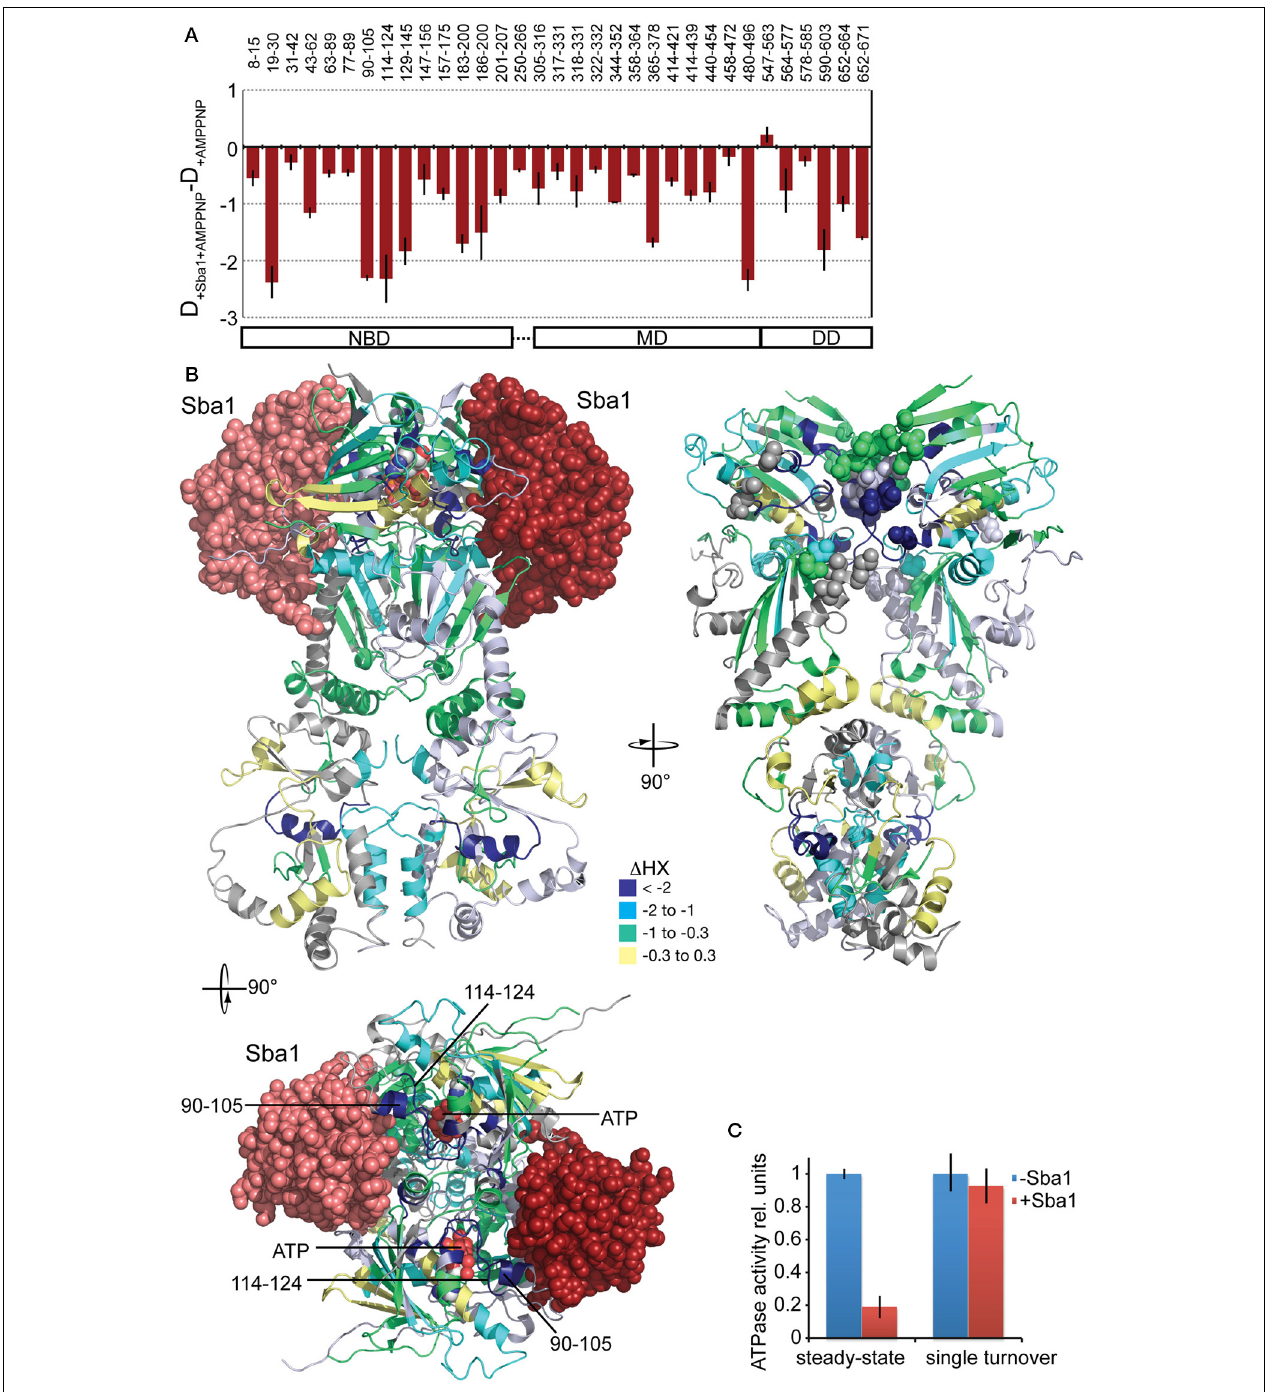
FIGURE 9 | Effects of Sba1 and AMPPNP on the conformational dynamics of yHsp82. (A) Difference plots of deuterons incorporated into yHsp82 in the presence of Sba1 and AMPPNP minus deuteron incorporation in the absence of Sba1 but presence of AMPPNP after 30s HX. The numbers on top indicate the corresponding peptic peptides, the domain structure is shown on the bottom. Error bars represent standard error of three independent experiments. (B) Left panel, crystal structure of yHsp82 (cid:2) (221–255)-A107N (cartoon representation) in complex with Sba1 (spheres) and AMPPNP. Right panel, same structure rotated as indicated